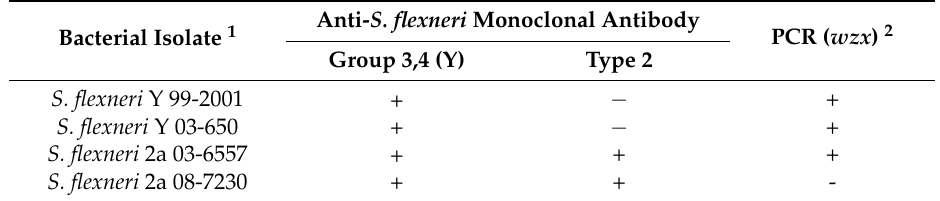
Table 1. Shigella flexneri natural isolates characterized by slide agglutination with monospecific antibodies and PCR-based genetic